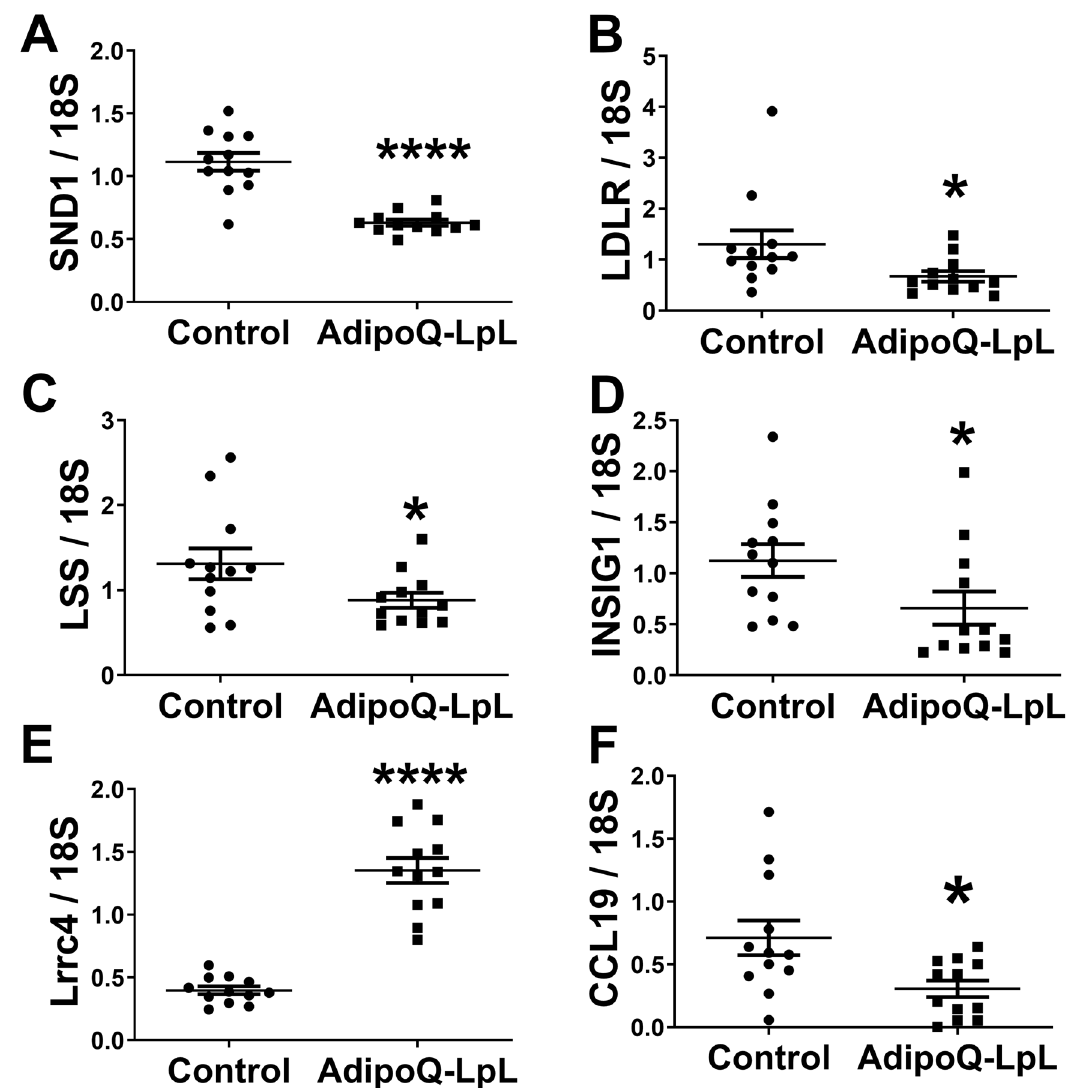
Figure 3. Confirmation of the microarray results. mRNA expression in perigonadal fat of control and AdipoQ- LPL mice on chow or high fat diet (10-days) was measured by real-time RT-PCR. The data are represented as the mean ± SEM of gene expression normalized to 18S (n = 12). mRNA expression of ( A ) SND1, ( B ) LDLR, ( C ) LSS, ( D ) INSIG1, ( E ) Lrrc4, and ( F ) CCl19 is indicated (*P < 0.05; ****P < 0.0001; two-tailed unpaired Student’s t-test). Data for Ccl19 is log10